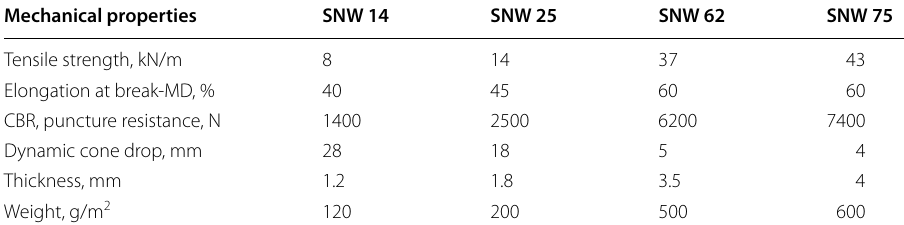
Table 3 Properties of superior needle-punched nonwoven geotextiles (SNW series) Mechanical properties